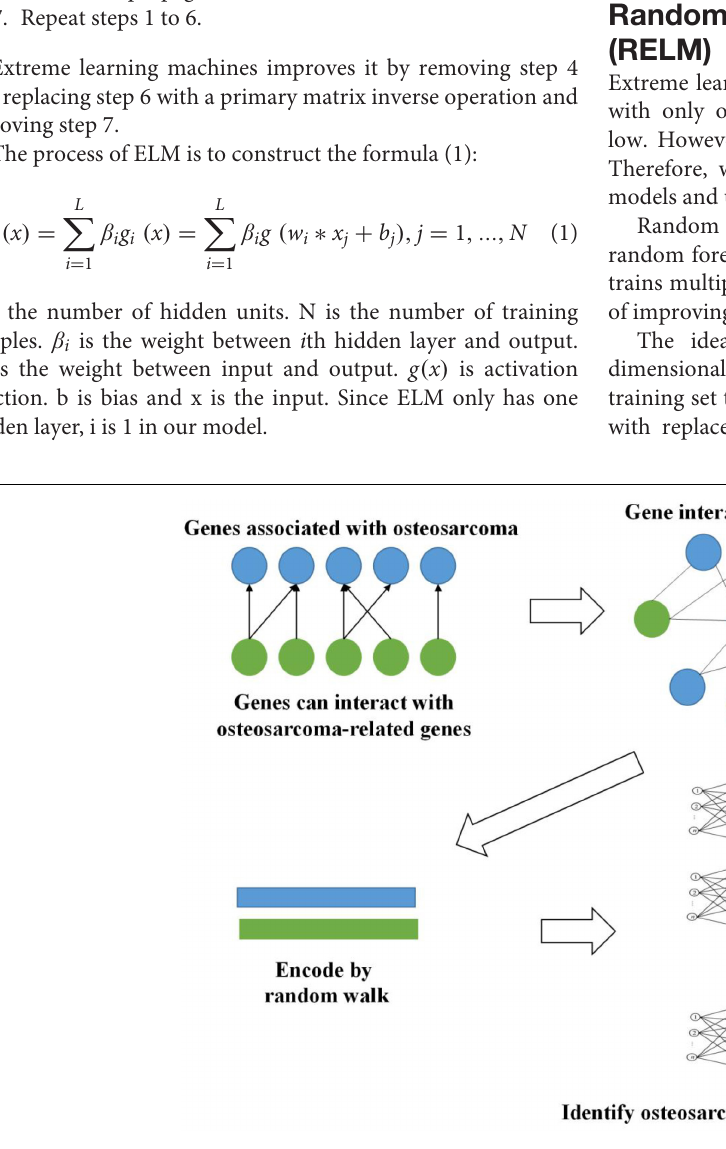
FIGURE 1 | Workflow of our